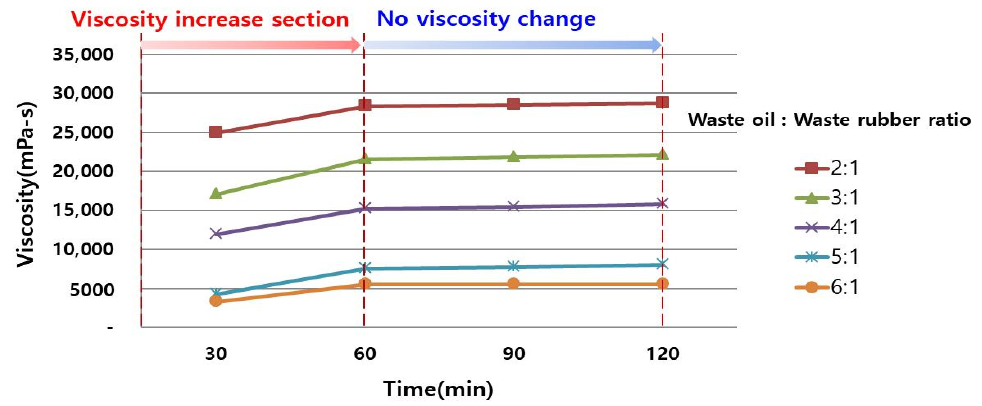
Figure 6. Variation in viscosity with melting time.